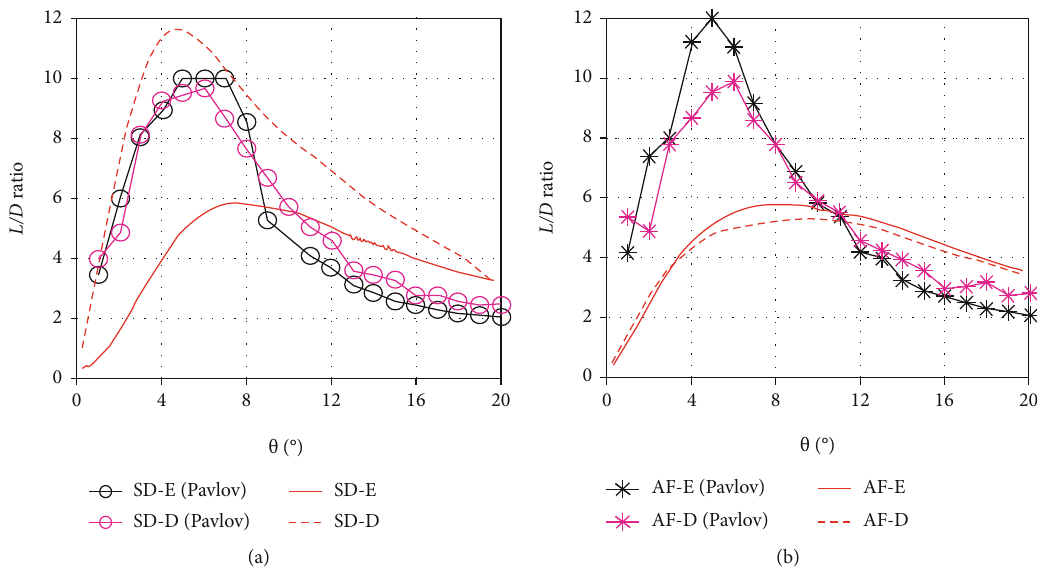
Figure 15: Comparison of current results with the simulation data of Pavlov: (a) the L / D ratio of the second dorsal fi n; (b) the L / D ratio of the anal fi